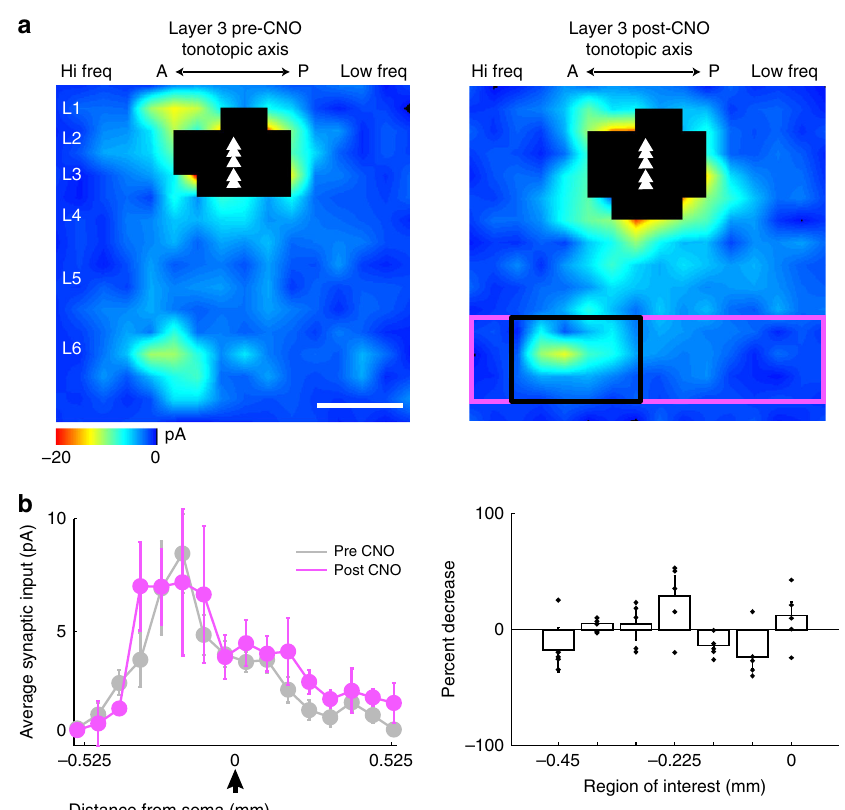
Fig. 7 Chemogenetic silencing of L6-Ntsr1 input to L3. a Average population input maps of L3 neurons before (left) and after (right) presynaptic silencing of Ntsr1 input with CNO infusion into the bath. Scale bar 0.3 mm. b , left Columnar average of synaptic from L6 (boxed pink region in panel A right) to L3 before and after CNO infusion ( n = 5 cells, fi ve mice). b , right The percent decrease in out-of-column L6 input (boxed black region in ( a ) right) to L3 was largely unchanged after CNO infusion. All data are presented as mean ±